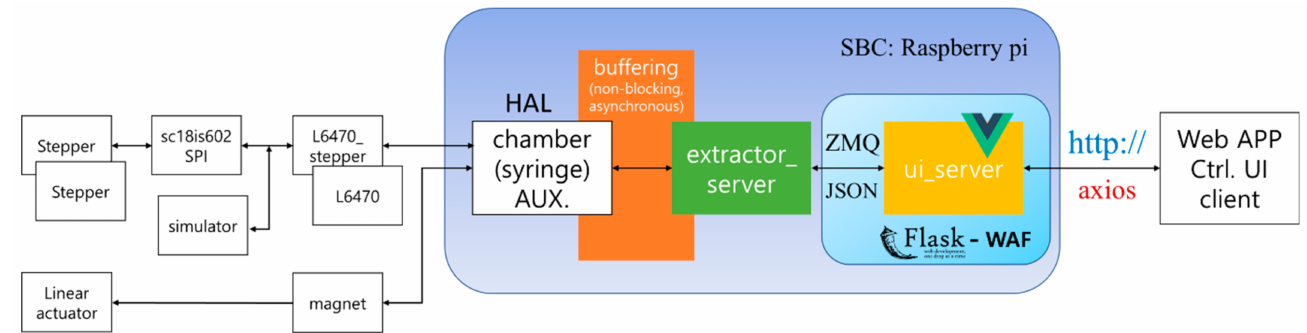
Figure 3. DNA extraction system block diagram. A hardware abstraction layer (HAL) directly drives the motor driver and auxiliary (AUX.) devices such as Liner actuator and magnet. Flask is a micro web application framework (WAF) written in Python. It communicates HTTP with the web application control (Ctrl.) UI